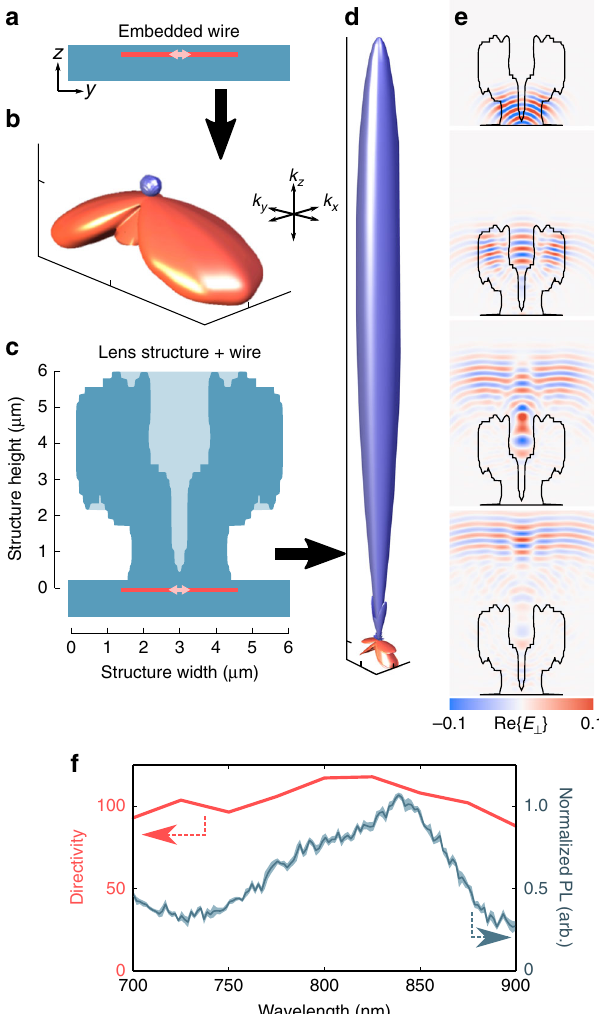
Fig. 2 Nanophotonic lens performance. a Cross-sectional diagram of a 80 nm diameter, 3 μ m long GaAs nanowire (red) with 250 nm emitting region (pink), embedded under 200 nm of polymer, on glass. b Normalized emission plot of dipole emission originating from the center of the nanowire. The upper (blue) region corresponds to emission into the upper hemisphere, whereas the lower (red) region corresponds to emission into the substrate, expressing a directivity of 0.75. c Cross-sectional schematic of the nanowire with the nanophotonic lens present. d Emission diagram from the nanowire – nanolens system, showing an enhanced directivity of 101. The two emission diagrams show the same total integrated emission within 5%. e Simulated propagation of normalized light emission through a nanolens structure (outlined, red) in four time snapshots, showing the presence of re fl ection and refraction (snapshot 1 – 3), and interference (2 – 4) effects. f Directivity into the surface normal as a function of wavelength, overlaid with the photoluminescence spectrum of the nanowire emitters used in the experiments, showing broadband response over the nanowire emission range (small shaded region is the standard deviation over 10 sample